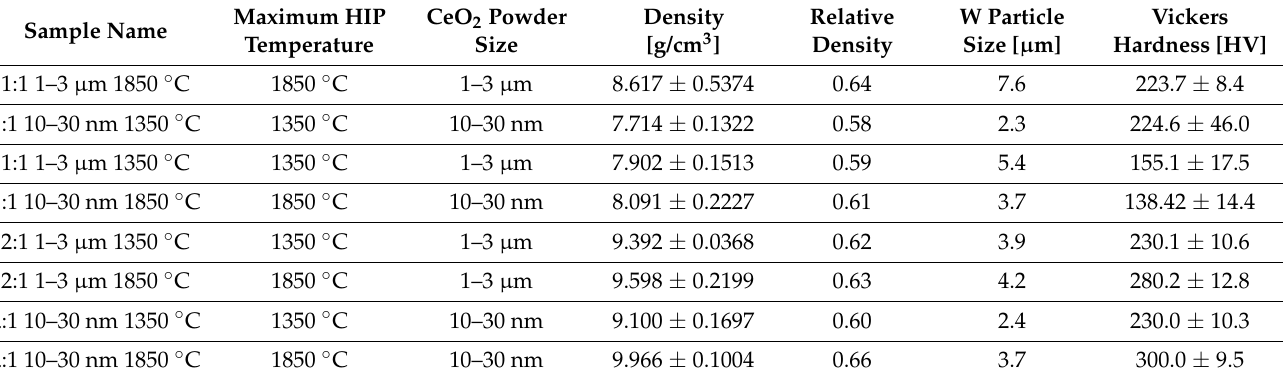
Figure 3. Density as a function of W-CeO 2 ratios showing an increase in CeO 2 content decreases the density. Sintering at higher temperatures enhances (Profile B) systematically increases the relative density regardless of starting CeO 2 particle size. Table 1. HIP processing routes explored for the W-CeO 2 metal matrix composites and the resulting density, microstructure, and